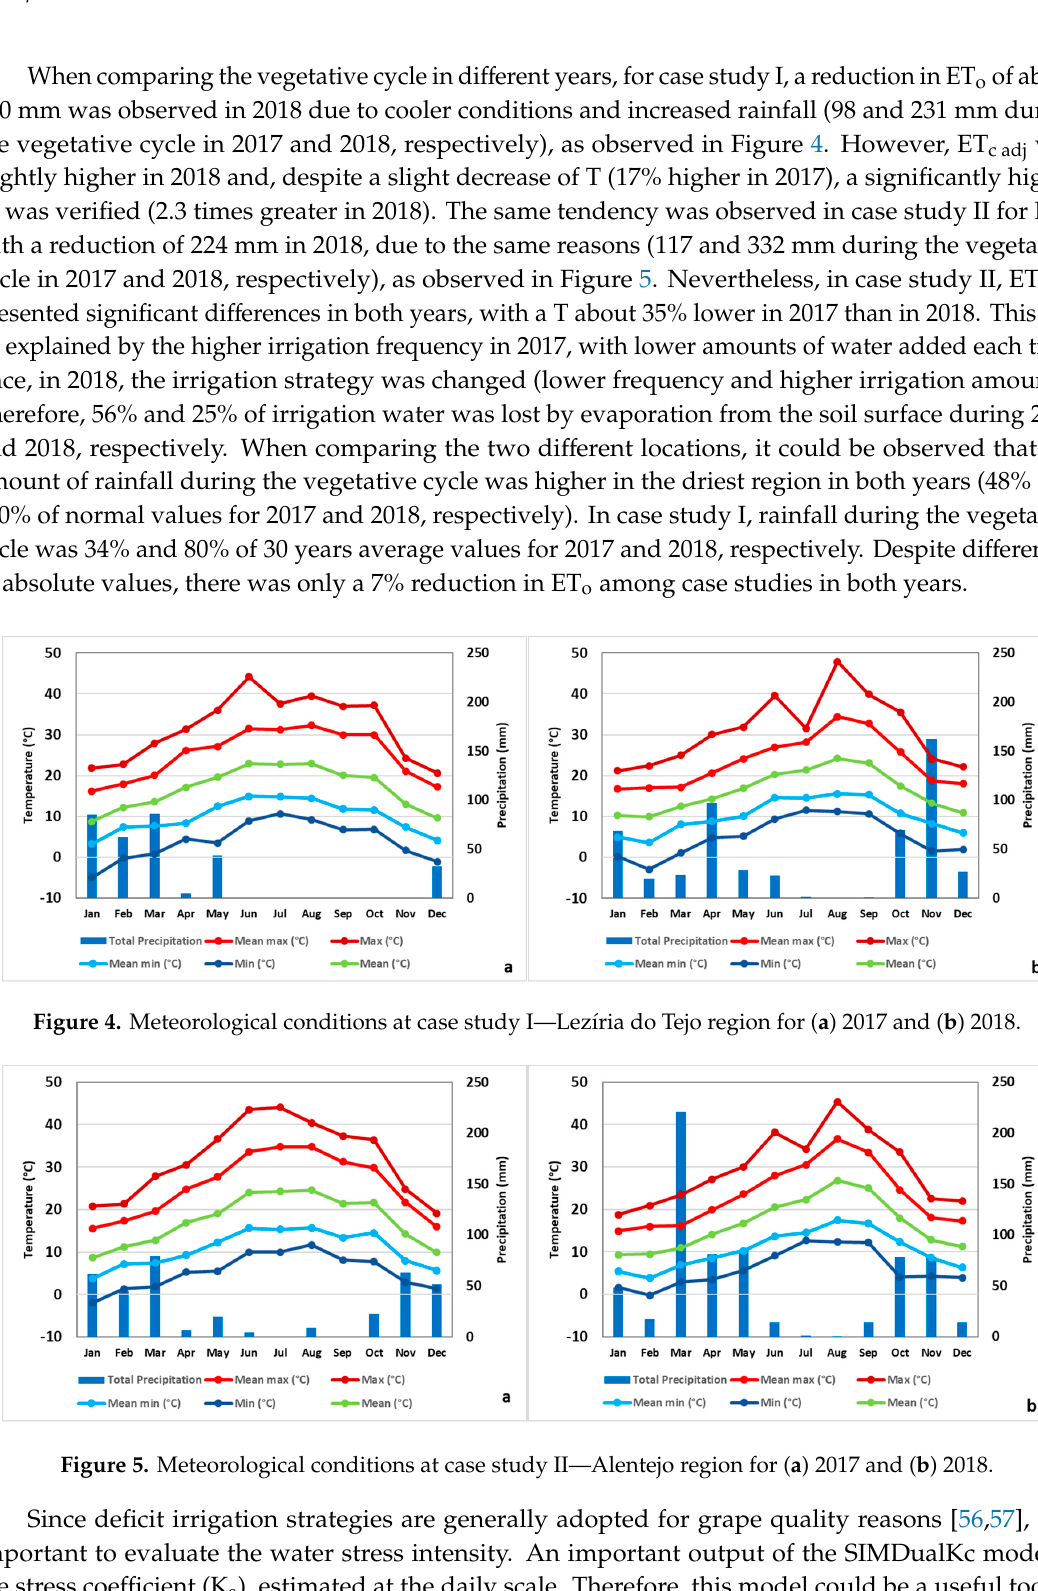
Figure 6. Seasonal evolution of stress coefficients, estimated by the SIMDualKc model, at case study I and II, during the vegetative cycles of 2017 and 2018. The suitability of the irrigation strategy followed can also be assessed by soil evaporation, in particular, that associated with irrigation, since a strategy with a higher number of irrigations (with a correspondent lower volume) would contribute to a higher water volume content at soil’s top layers, resulting in a higher soil evaporation. At case study I (sandy soil with a high hydraulic conductivity), the irrigation frequency was weekly and irrigation water lost by evaporation was about 8% in both years. At case study II (clay soil), the irrigation was carried out every two days with lower water amounts and around 56% and 25% of irrigation water was lost by soil evaporation in 2017 and 2018 respectively, contributing to a less efficient use of irrigation water. One can conclude